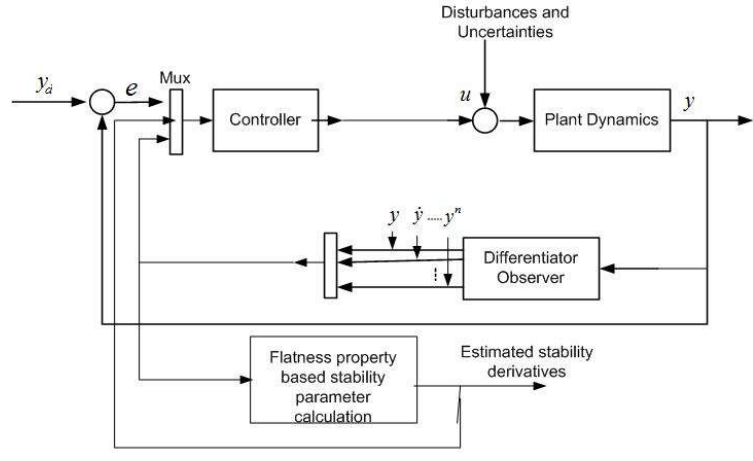
Figure 7. The proposed system identification approach in stability derivative estimation.